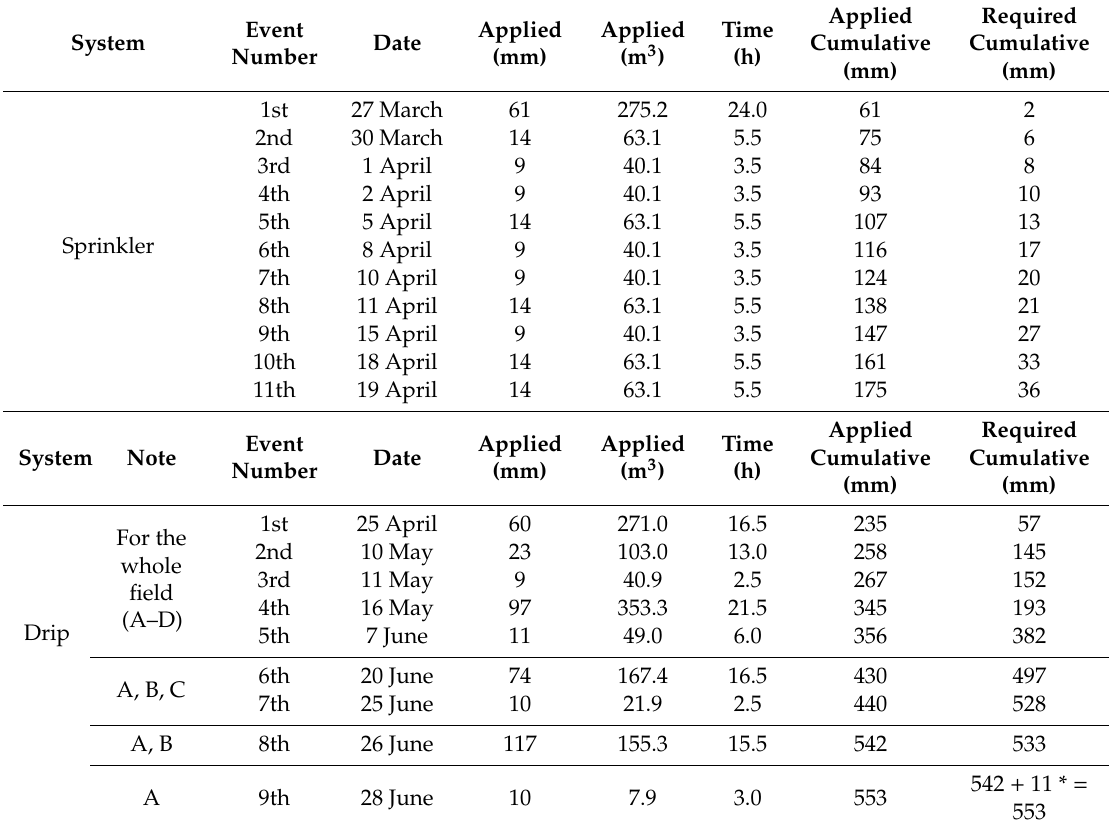
Table 4. ET C calculations and irrigation scheduling during the growing